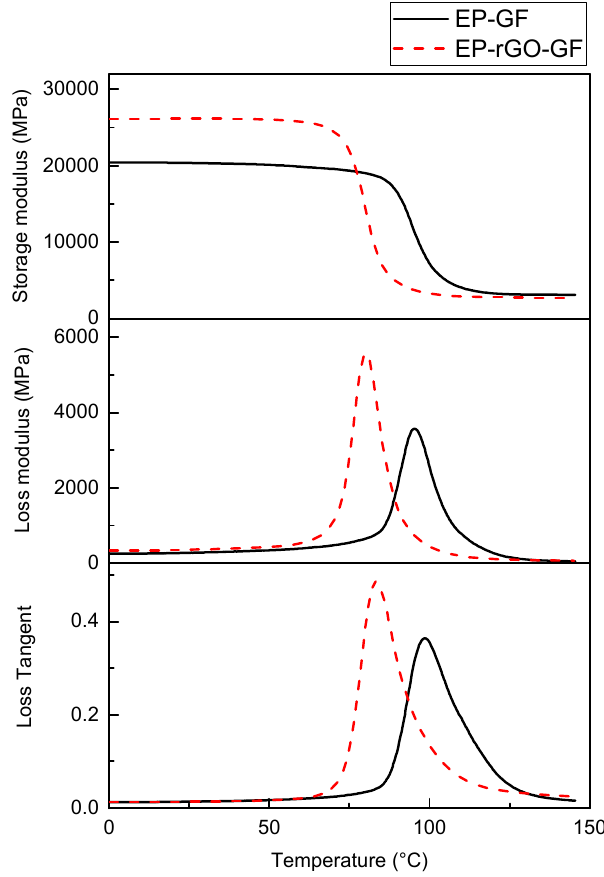
Figure 5. Storage modulus, loss modulus, and loss tangent curves from dynamic mechanical analysis (DMA) on the prepared composites.